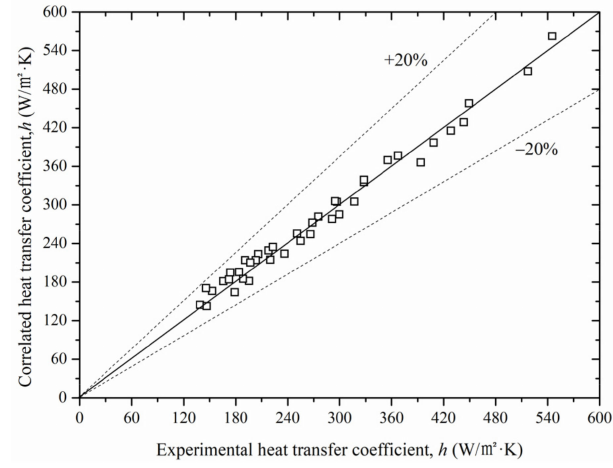
Figure 7. Comparison of correlation against experimental data.